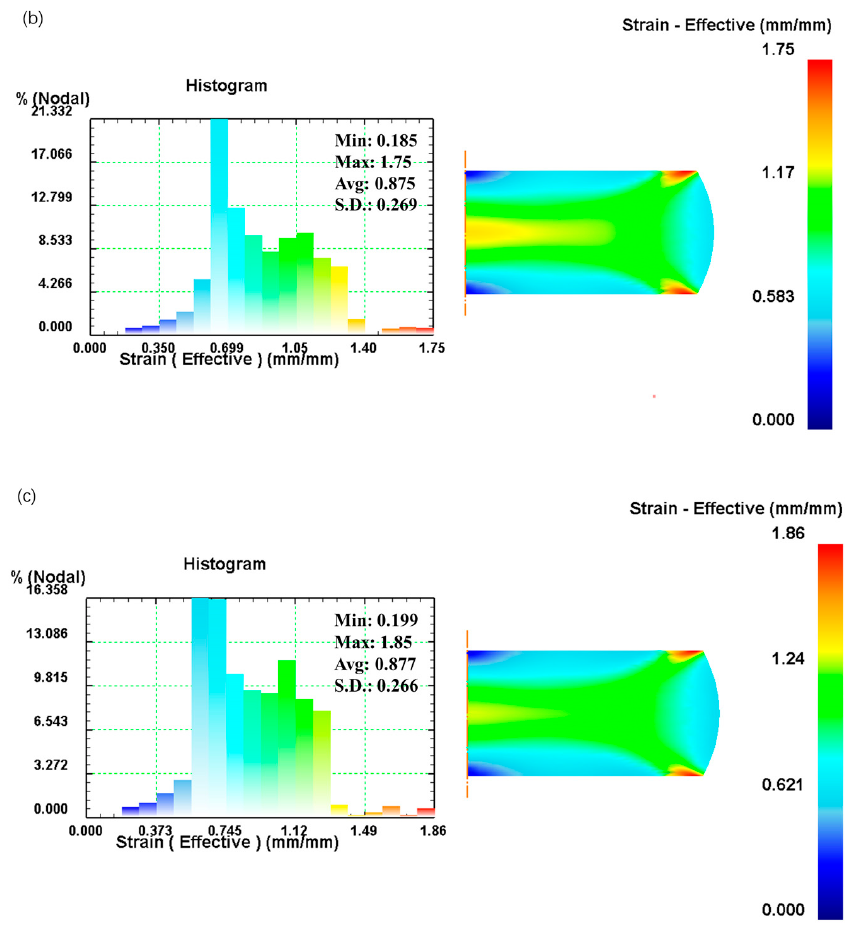
Materials 2023 , 16 , 2982 Figure 15. Distributions of effective strain for ( a ) scheme-A, ( b ) scheme-B, and ( c ) scheme-C, at the strain rate of 0.1 s − 1 , the temperature of 1303 K, and the height reduction of 60%. In addition, as shown in Figure 16, the load curves corresponding to the upper die stroke for each scenario show that the upper die load curve for scheme-B is very close to that of scheme-A. However, the di ff erence in top die load between scheme-C and scheme- A is large. The relative error of top die load between scheme-A and scheme-B ranged from − 0.7090%~3.3506%, and the relative error of top die load between scheme-A and scheme- C ranged from − 8.1880%~ − 4.1680%. Both Scheme-A and scheme-B are closer to the exper- imentally measured force versus die displacement curves, while scheme-C has a larger gap. It also can be seen from Figure 16 that too large an interpolation span or insu ffi cient stress-strain data can lead to inaccurate simulation results. It shows that PSO-BP inte- grated model can enrich the fl ow stress data, reduce the interpolation interval, and im- prove the simulation accuracy.